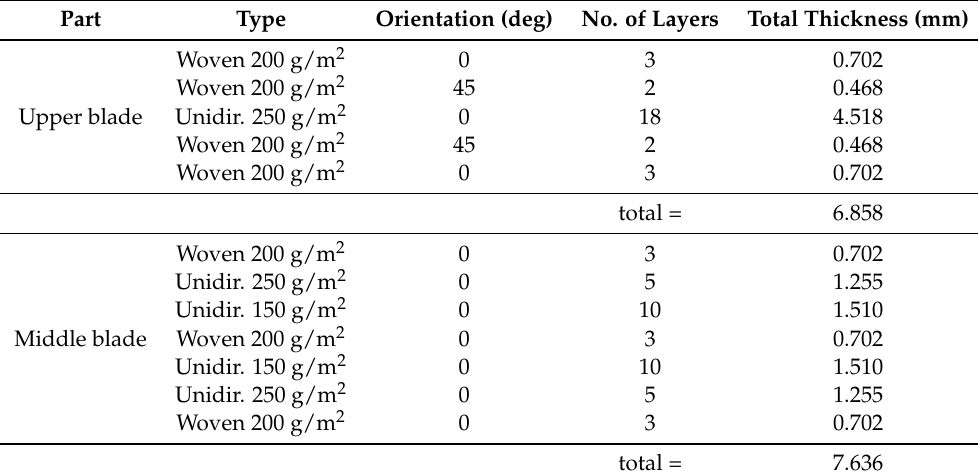
Table 8. Final lamination sequences of the upper blade and the middle blade. The properties of the three types of CFRP prepregs are listed in Table 5. The directions of the fibers and the stack up for the upper blade and middle blade are depicted in Figure 14.